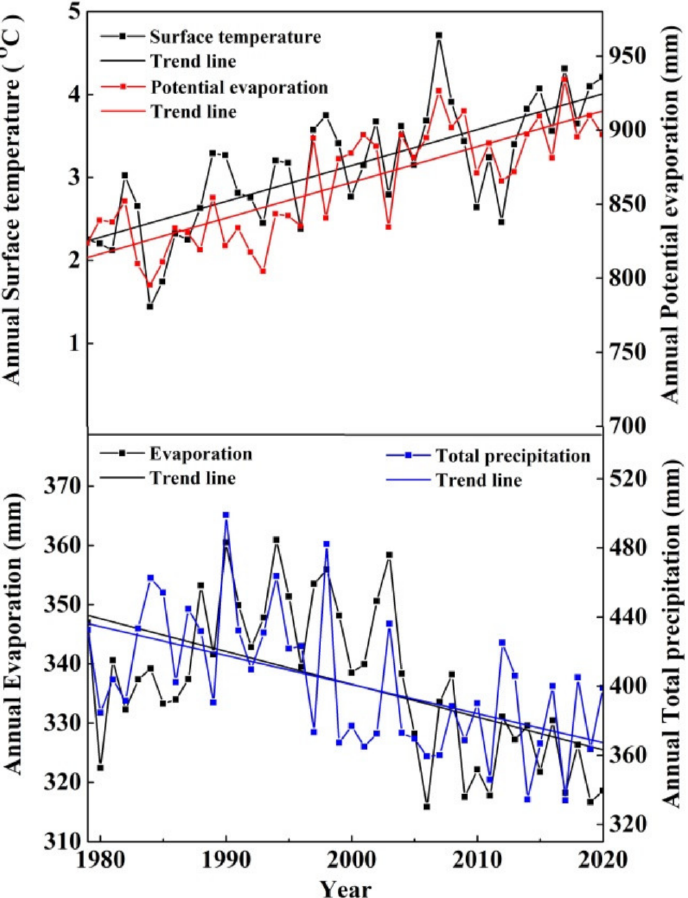
Figure 9. Temporal distribution of the surface temperature, potential evaporation, total precipitation and evaporation over the MP and surrounding areas during the period of 1979–2020. We used the linear regression method to calculate